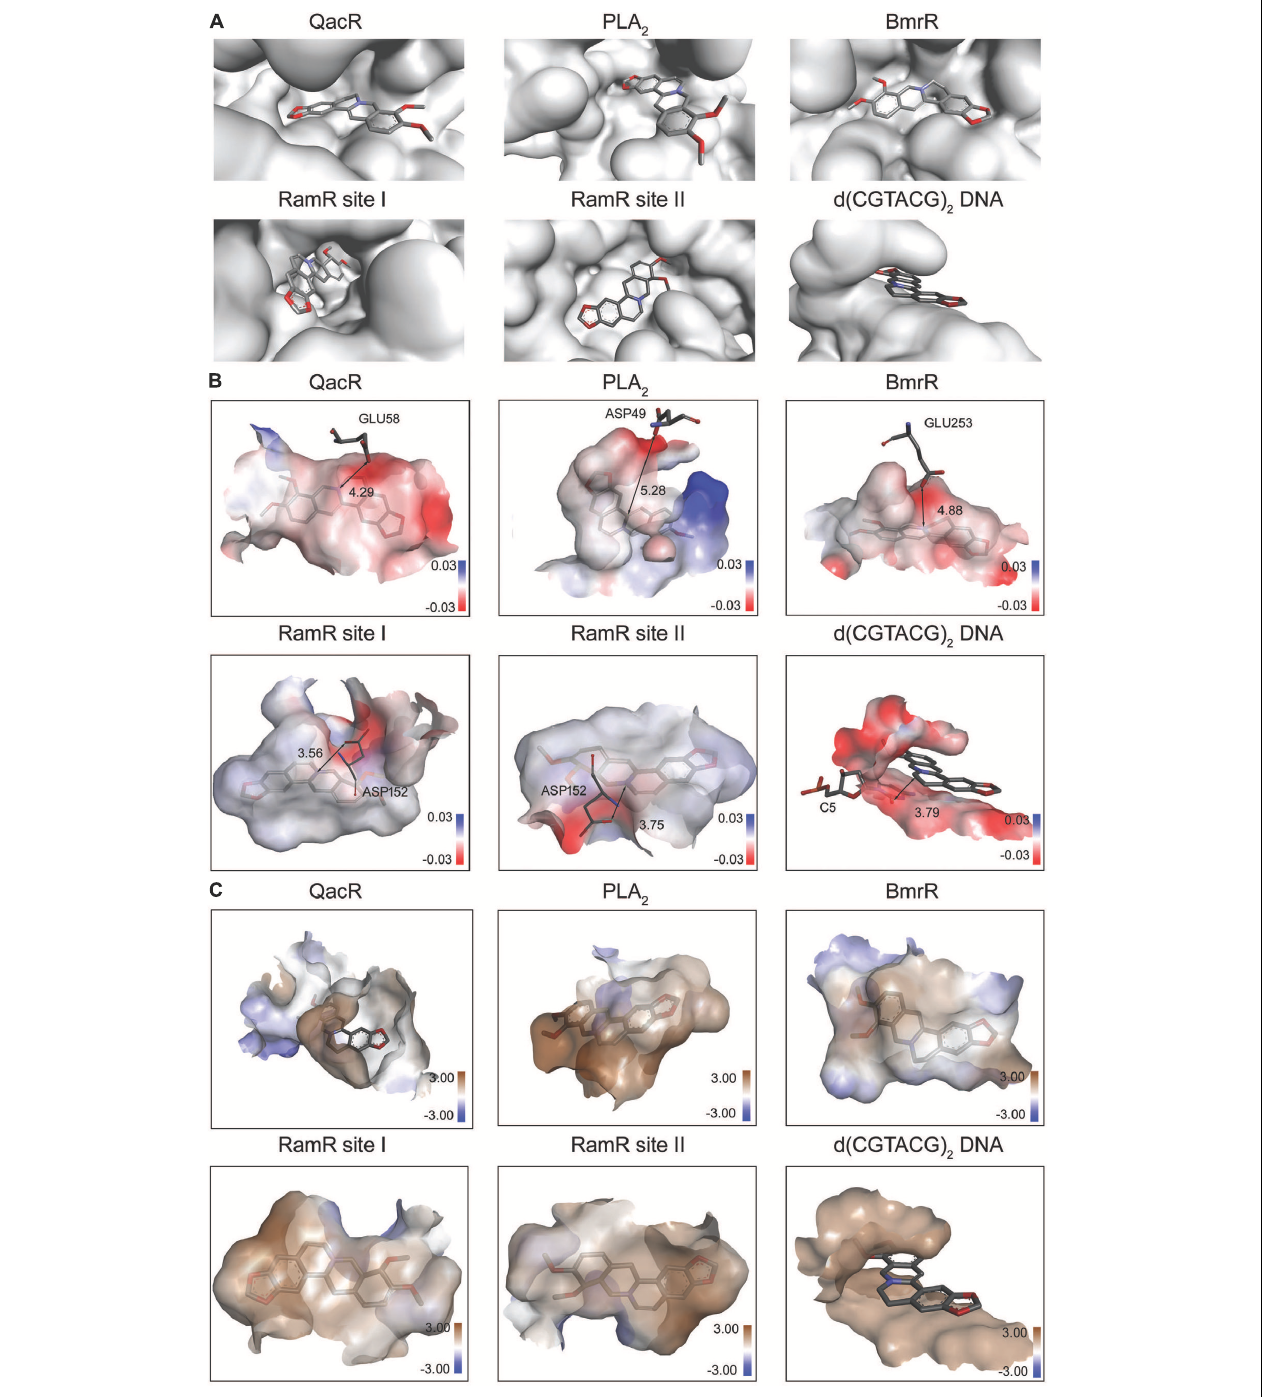
FIGURE 1 | The physicochemical properties of multi-target binding pockets with berberine. Berberine is shown as sticks with carbon, oxygen and nitrogen colored gray, red and blue, respectively. (A) The substrate-binding sites of QacR, PLA 2 , BmrR, RamR, and d(CGTACG) 2 DNA in complex with berberine. Two binding sites appeared in RamR, including site I and site II. (B) The chemical properties of multi-target binding pockets in complex with berberine. The surfaces are shown in gradient colors, where electropositivity is colored blue, and electronegativity is colored red. The key anions are labeled and depicted as sticks. (C) The physical properties of multi-target binding pockets in complex with berberine. The surfaces are shown in gradient colors, where hydrophobia is colored brown, and hydrophile is colored blue.